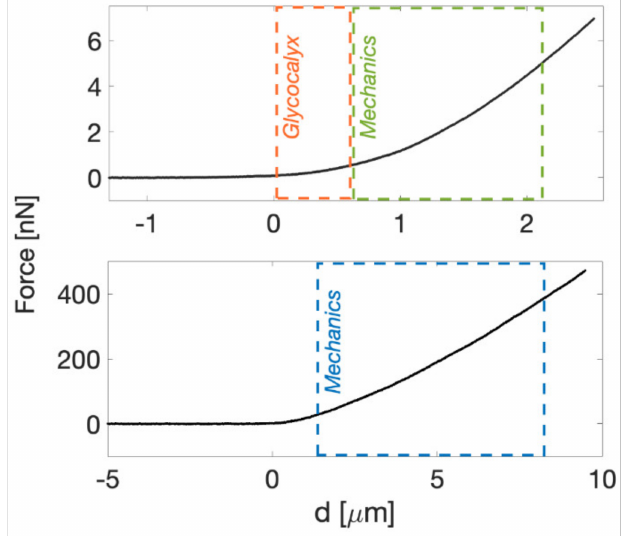
Figure 2. Typical approaching force curve on top of a cell ( top ) and ECM ( bottom ). The indentation range for model fitting is highlighted; on cells, we used typically [0–10%] for the glycocalyx and [10–80%] for the YM, while on ECMs we used [20–80%] for the Young’s